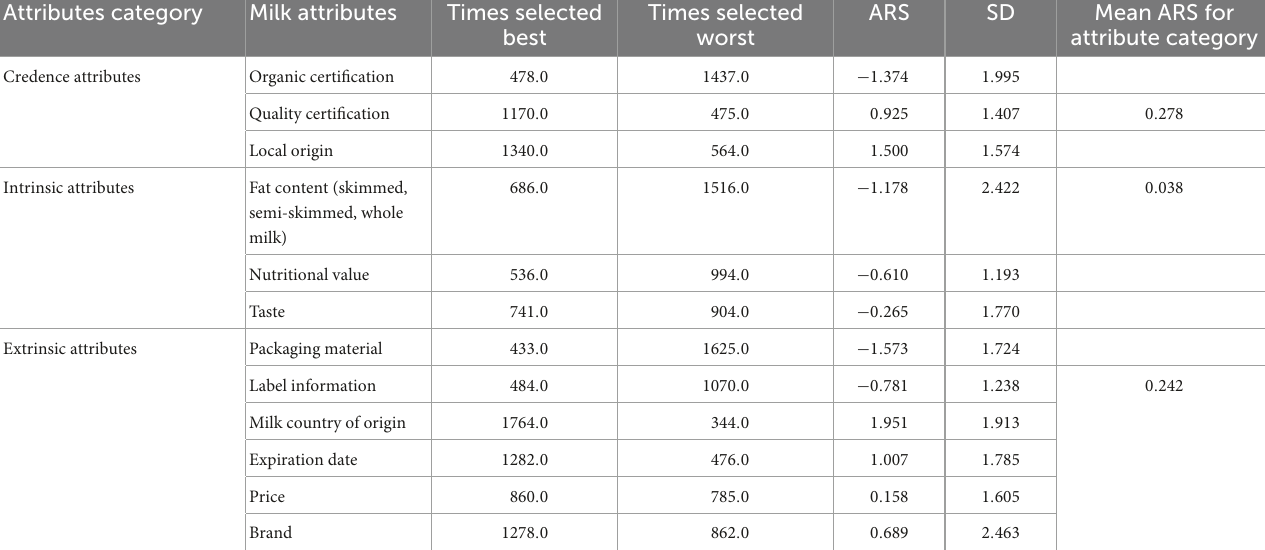
TABLE 3 Times selected best, times selected worst, and average raw score (ARS) for single attribute and attributes’ category are reported. Attributes